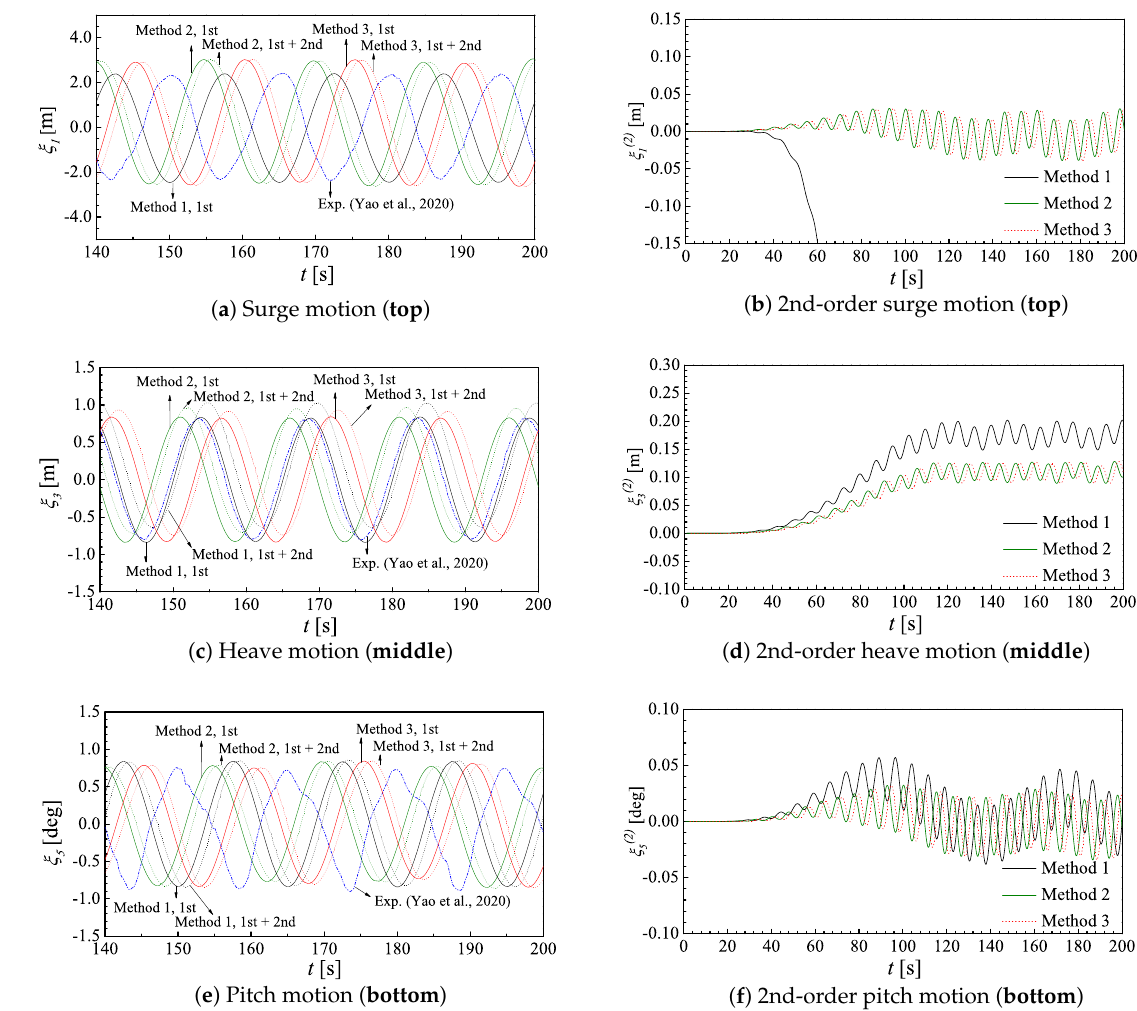
Figure 14. The 1st- and 2nd-order time series of the responses of the 6MW spar-type FOWT. The ( left ) column exhibits the comparison between the present results and experiments from [48]. Here, legends of figures only represent different methods. In addition, the solid lines ( ) are drawn for 1st-order results while the dotted lines ( · · · · · · ) are for results with the 2nd-order components included. The ( right ) column only displays the 2nd-order results determined by different methods.